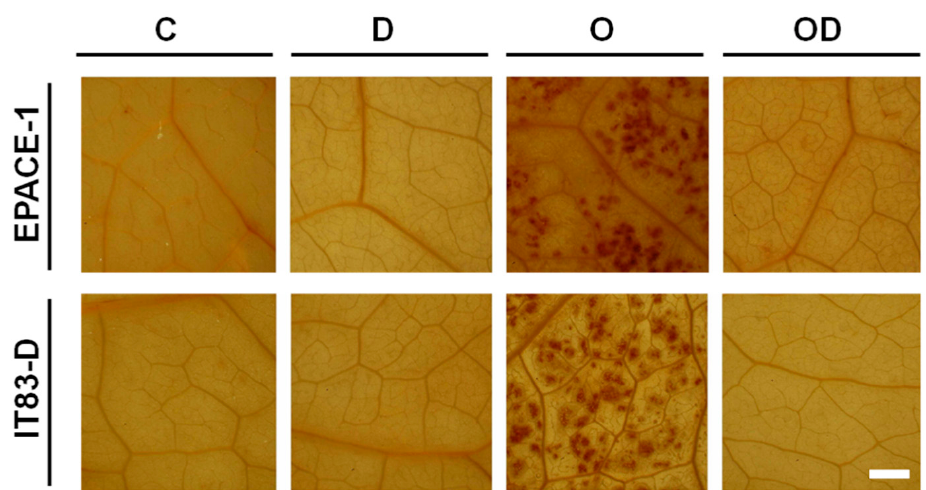
Figure A1: Detection of hydrogen peroxide using DAB staining; Table A1: MGDG and DGDG fatty acid composition; Table A2: Analysis of variance (ANOVA) of physiological parameters; Table A3: Analysis of variance (ANOVA) of lipid contents; Table A4: Analysis of variance (ANOVA) of gene expression data; Table A5: Description of genes analyzed by RT-qPCR.